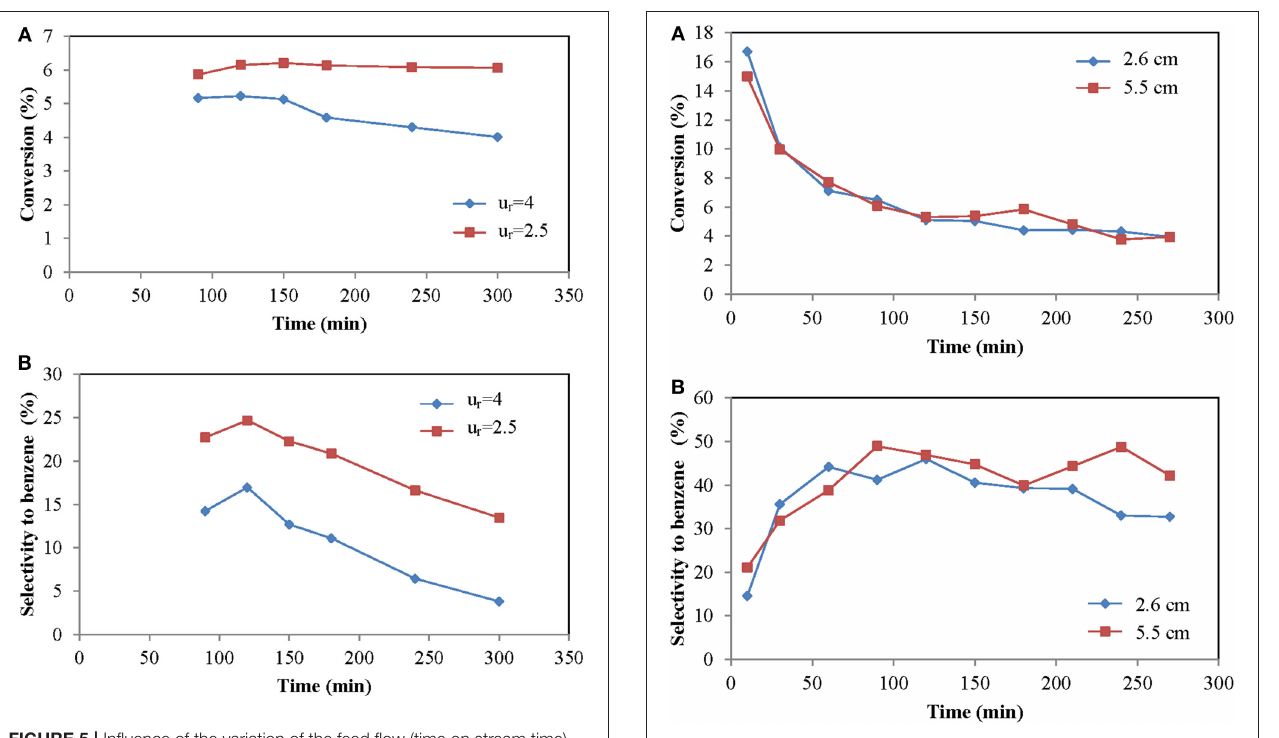
FIGURE 6 | Influence of the variation of the height of the rod in the TZFBR (time on stream): (A) Methane conversion, (B) Selectivity to benzene. Operational conditions: W cat = 14.5g, CH 4 :CO 2 :N 2 = 70:1:29, u rlowerzone = 2.9, u rupperzone = 5.6, and T = 700 ◦